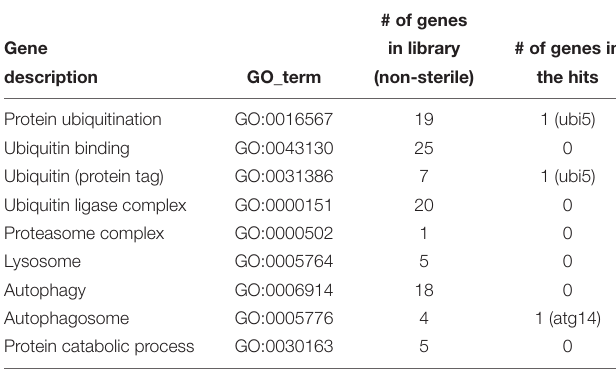
TABLE 3 | Genes related to global ubiquitination and degradation, as determined by GO terms, that are in the screen library or genetically interacting with ate1 .